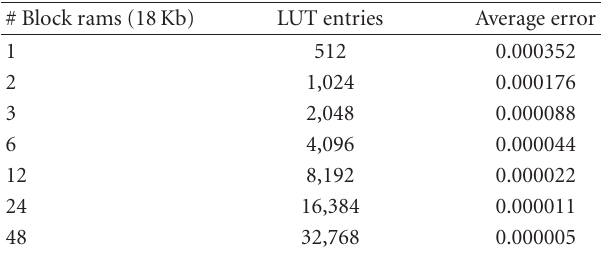
Table 2: Average LAU error and man LUT # of block rams.